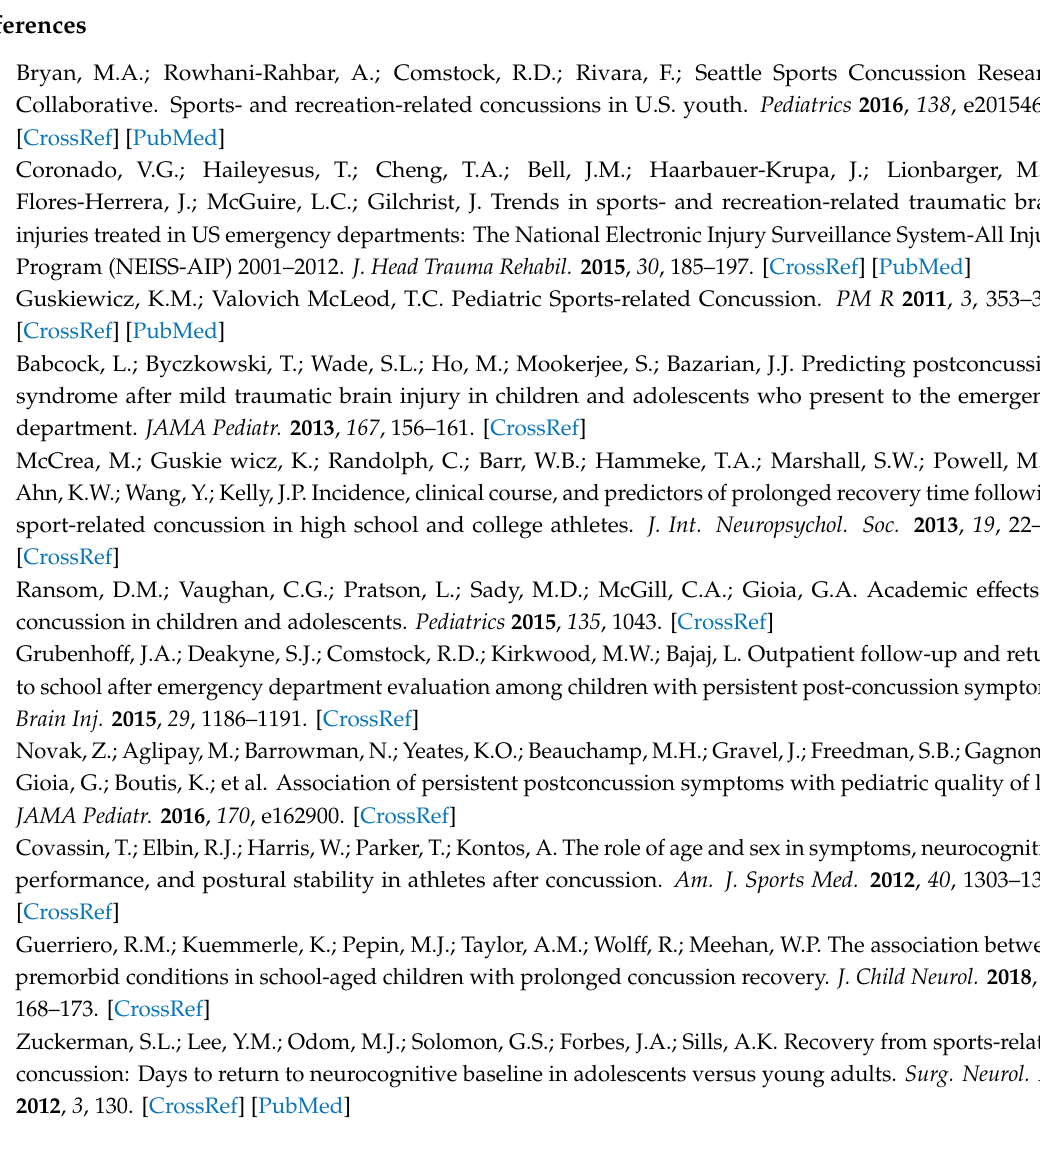
Table S1: Post-Concussive Symptom